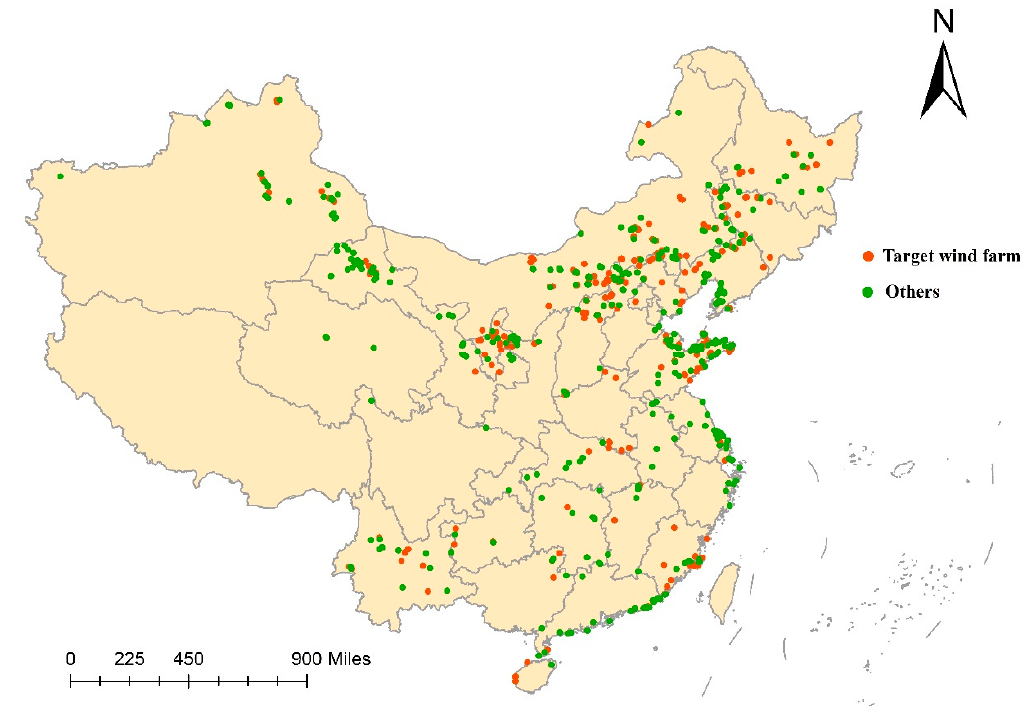
Figure 3. Distributions of wind farms by province. Table 2. Correspondence of MRIO and materials